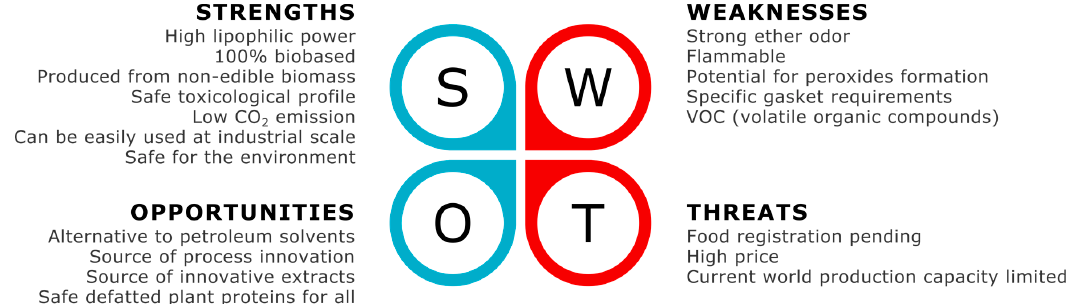
Figure 13. Strengths, weaknesses, opportunities, threats (SWOT) analysis (in 2020).